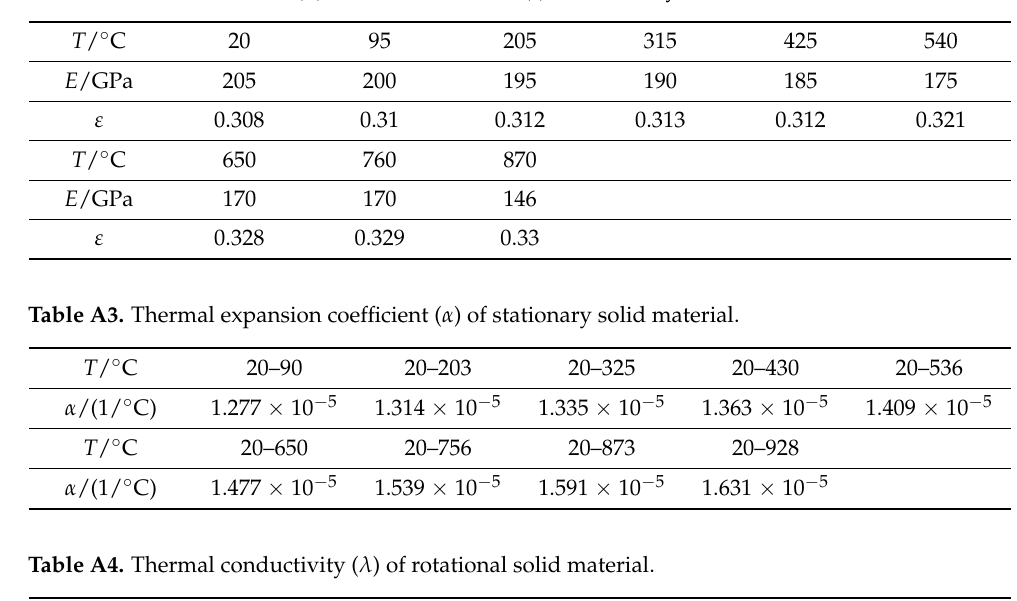
Table A2. Elastic modulus ( E ) and Poisson’s ratio ( ε ) of stationary solid material.